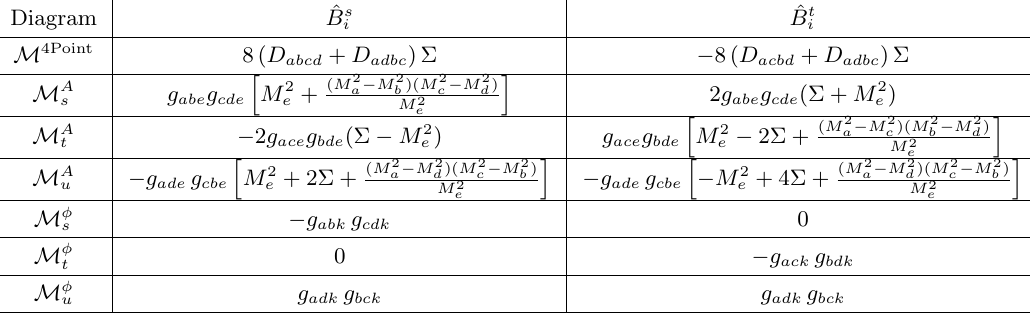
Table 6 . Coe(cid:14)cients ^ B i . We have de(cid:12)ned (cid:6) = ( M 2